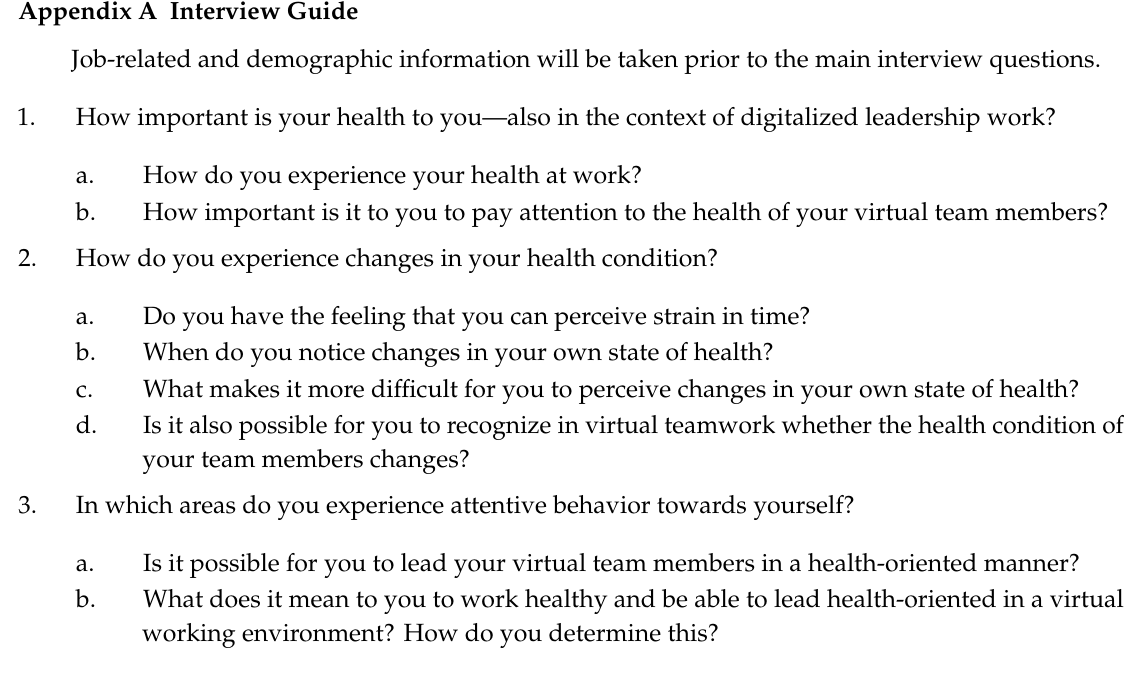
Table S1: COREQ (COnsolidated criteria for REporting Qualitative research)